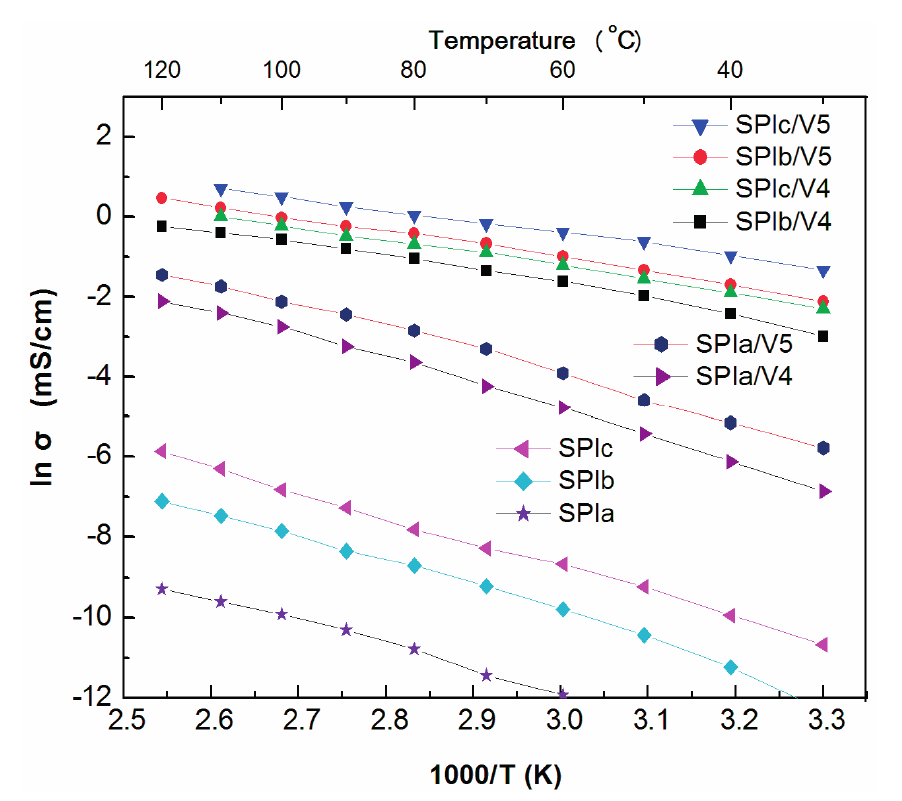
Figure 4. Temperature dependence of conductivity of SPIs and SPI/IL composite